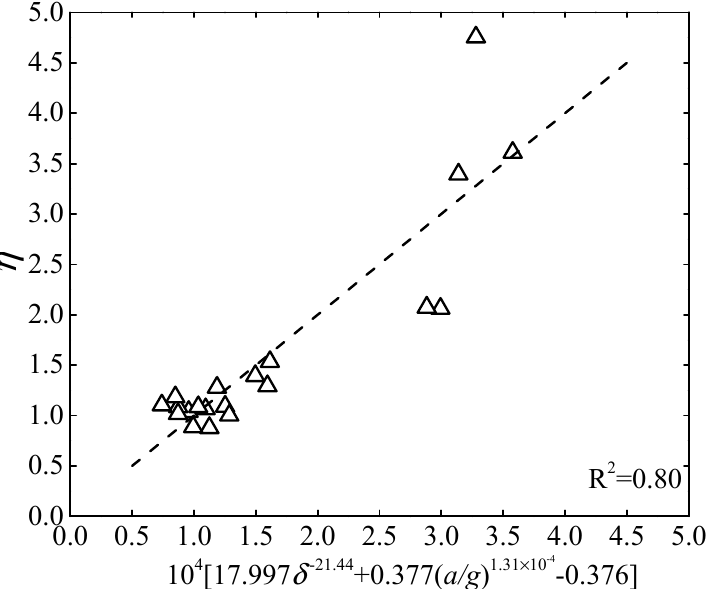
Figure 11. Relationship between particle mass ratio and original sediment particle size ratio and the flow velocity skewness in sediment transport results.